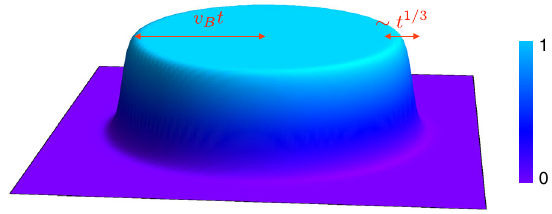
FIG. 3. Cartoon for the form proposed here for the OTOC in two spatial dimensions, when lattice anisotropy can be neglected. The functional form is given by the Tracy-Widom distribution F 2